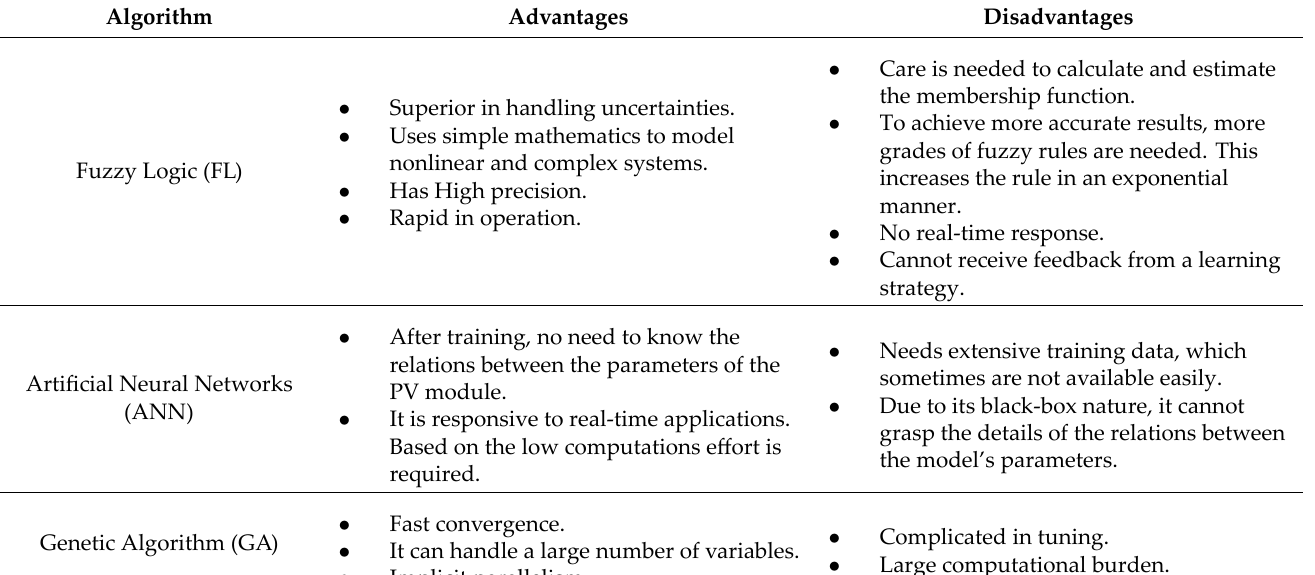
Table 11. Advantages and disadvantages of some of the optimization